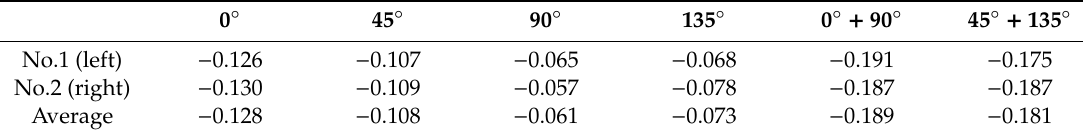
Table 5. Stress components in the local coordinate system.